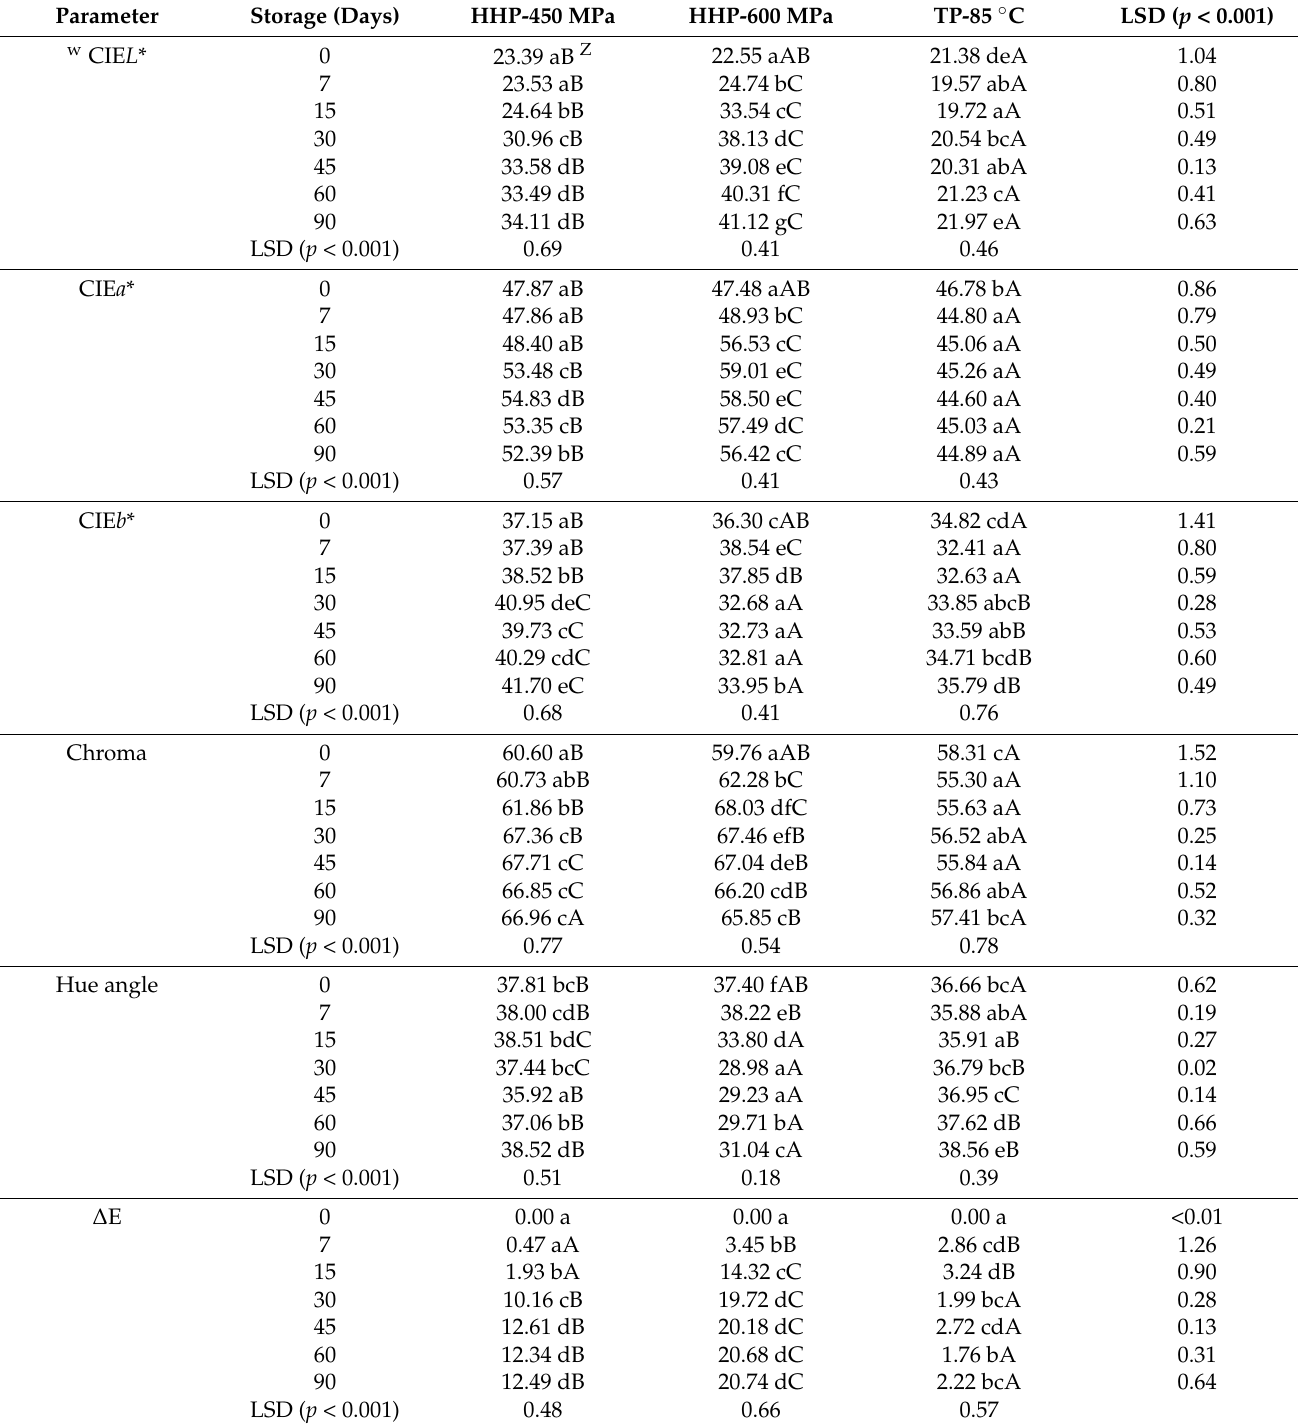
Table 5. Stability of CIE L * a * b * values in beverages stored at 4 ◦